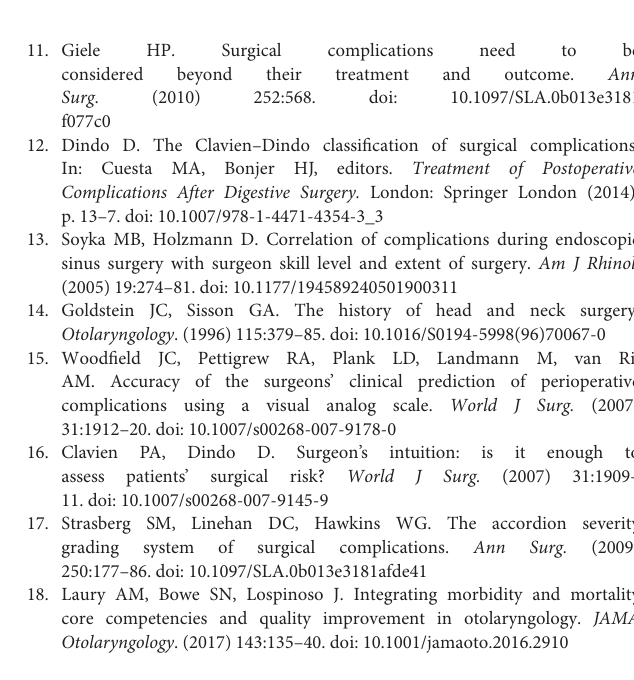
Supplementary Figure 1 | Relative frequencies of complication grading for cases 5, 6, 7, and 8. Cases 5 and 8 show good agreement with homogeneous distribution of gradings; meanwhile, cases 6 and 7 had a rather heterogeneous distribution of gradings. Supplementary Figure 2 | Residual plot for linear mixed-effects